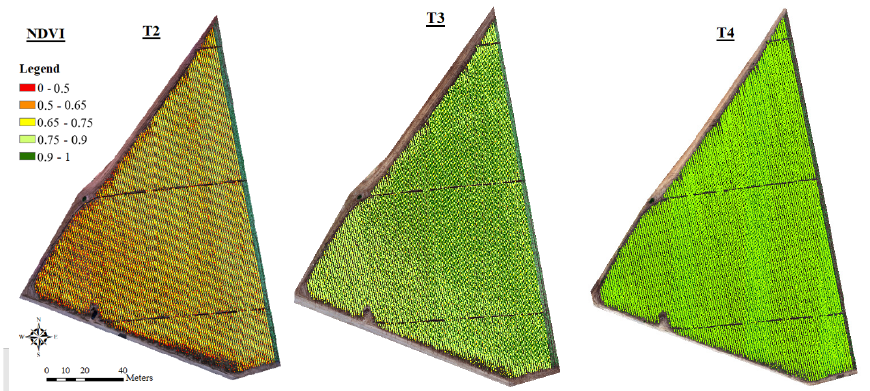
Figure 9. Map of the NDVI applied to vegetation for T2, T3, and T4.